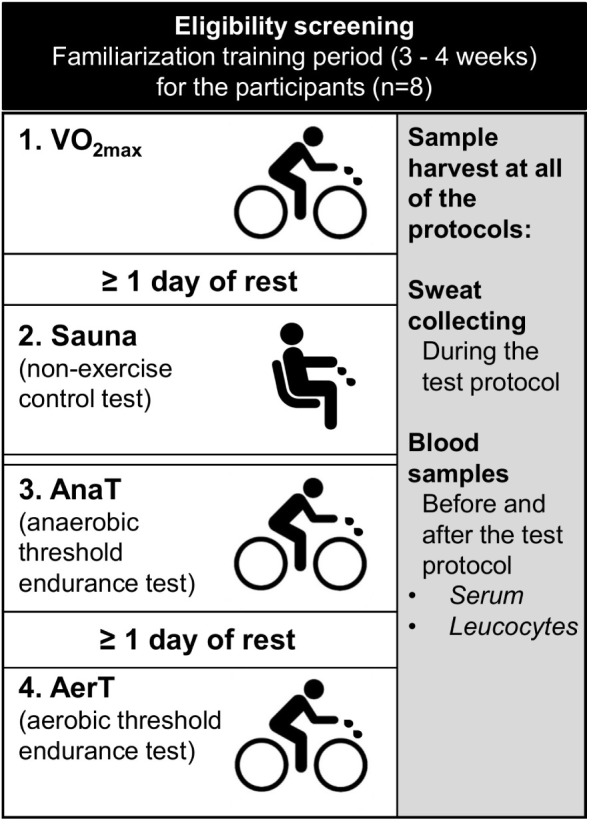
Schematic illustration of the study setup. After eligibility screening subjects (n = 8) went through a familiarization period followed by following tests in the same order: (1) VO2max test, (2) Sauna, (3) anaerobic threshold endurance test (AnaT), and (4) aerobic threshold endurance test (AerT). Same sample set was harvested in each of the tests.